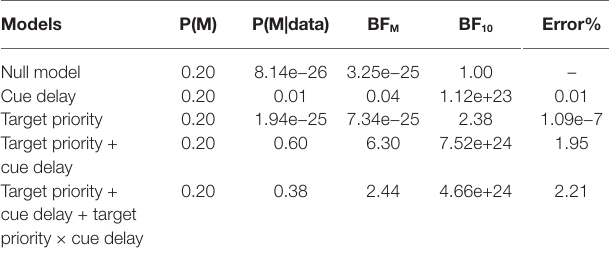
TABLE 2 | Model comparison for the Bayesian ANOVA on k